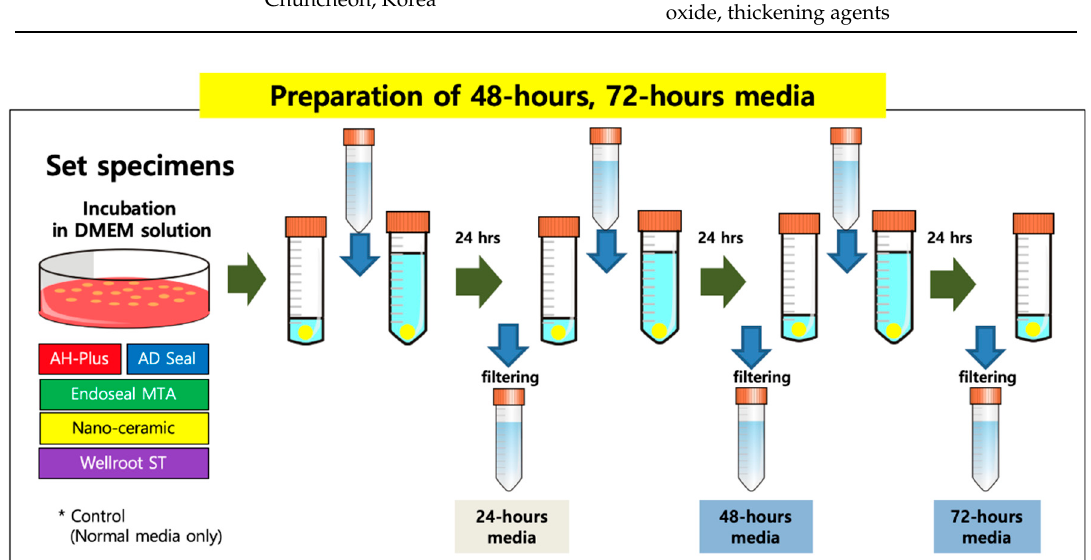
Figure 1. Preparation of set material extraction media. Each set sample disc was stored and incubated in Dulbecco’s modified Eagle’s medium (DMEM) solution. Every 24 h the medium was changed, and then the 48-h and 72-h extraction media were collected.